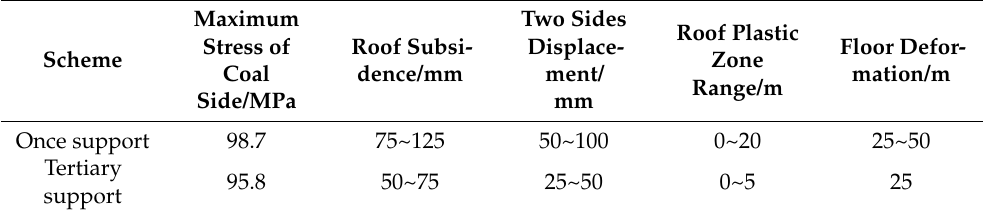
Table 3. Comparison of relevant parameters of different